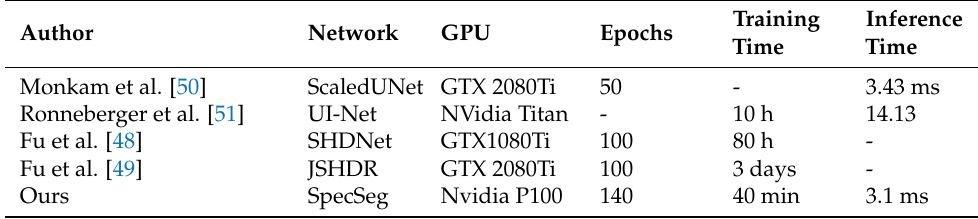
Table 5. Training and inference time comparison of different segmentation networks.